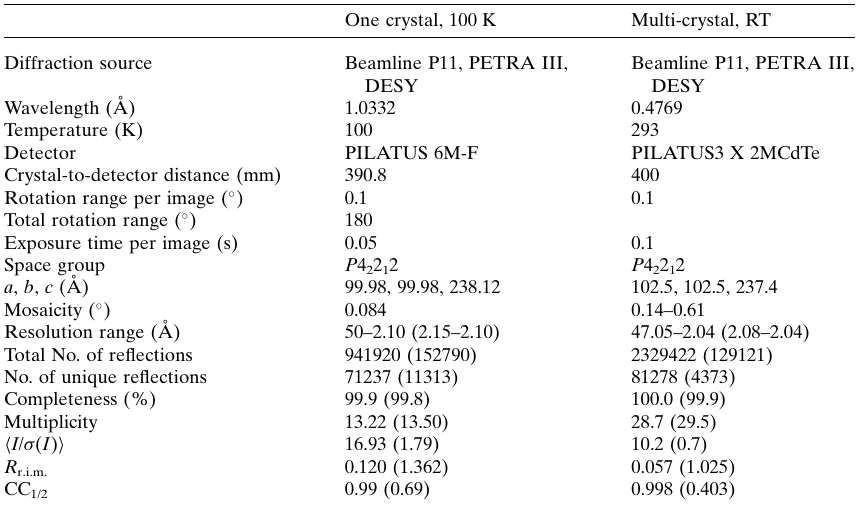
Table 1 Data collection and processing for F(M197)H RC. Values in parentheses are for the highest resolution